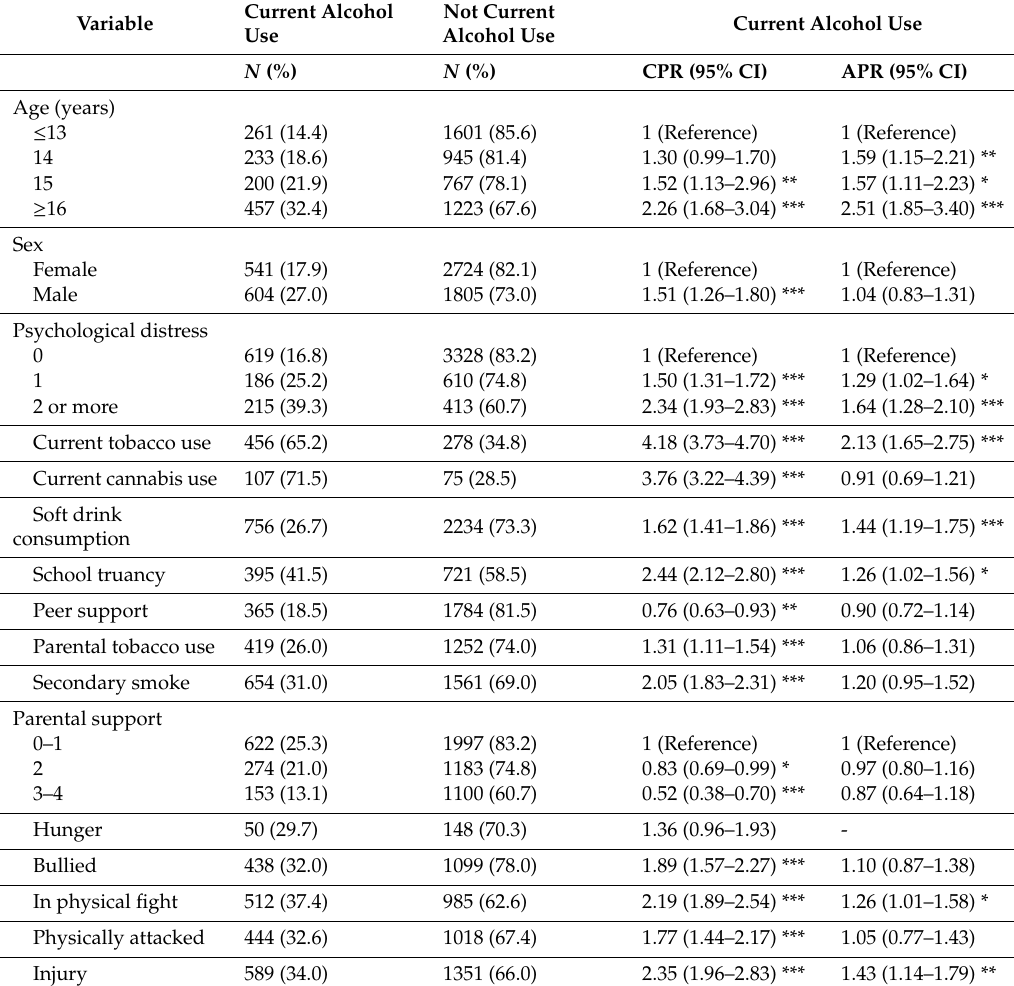
Table 3. Associations with current alcohol